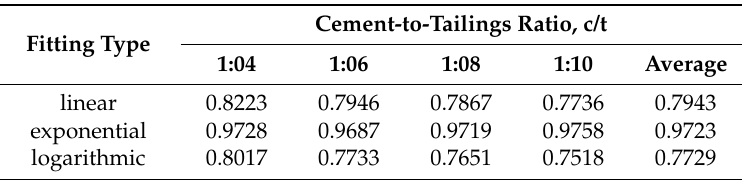
Table 6. Viscosity fitting results of CTB samples under various solid